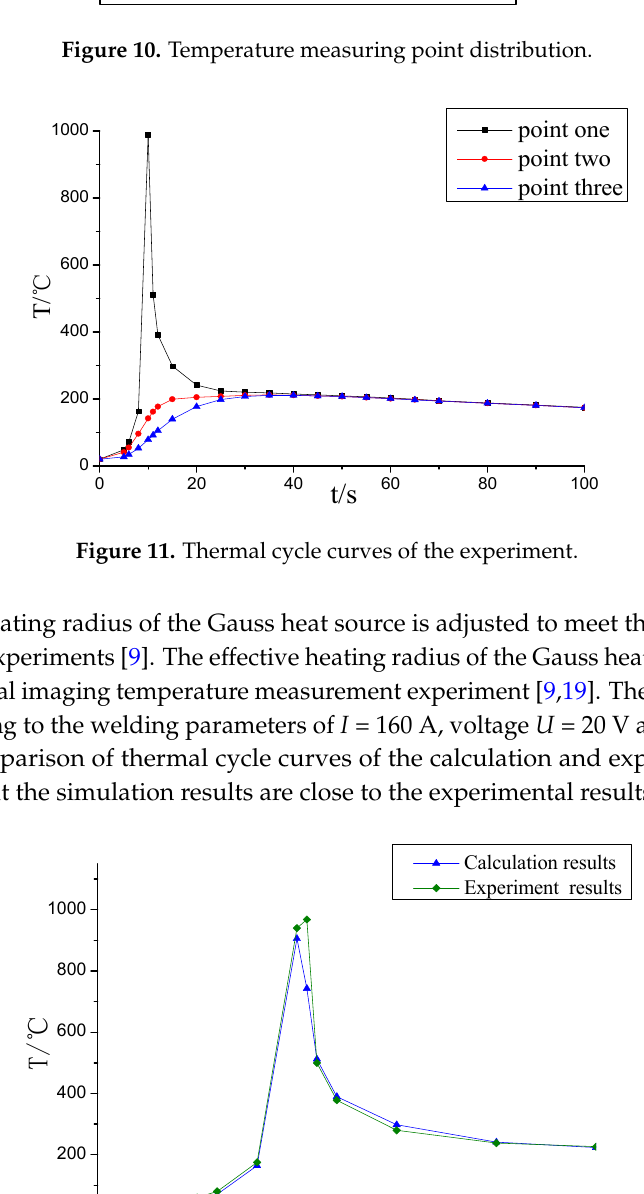
Figure 12. Comparison of thermal cycle curves of the calculation and experiment at point one.